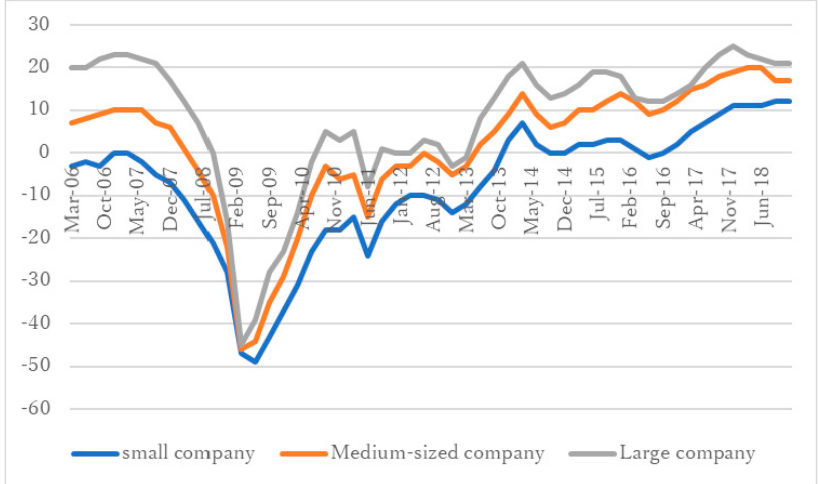
Figure 1 Business conditions diffusion index (All industries) 1 77